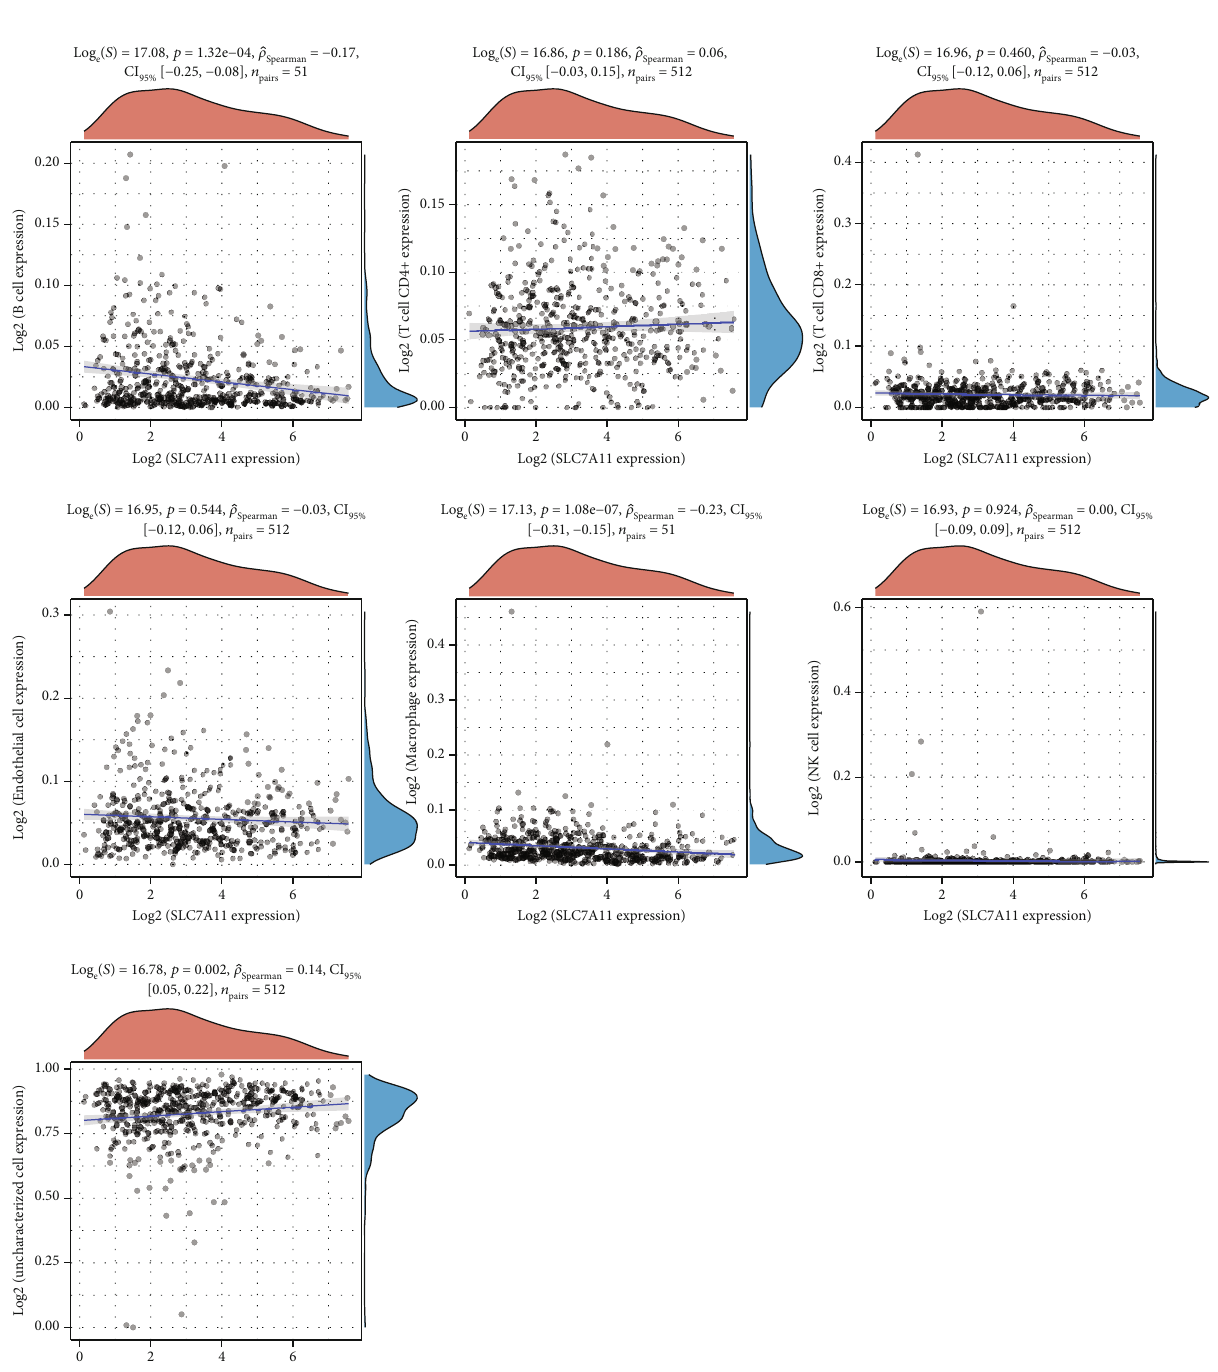
Figure 9: The association analysis between the expression of SCL7A11 and